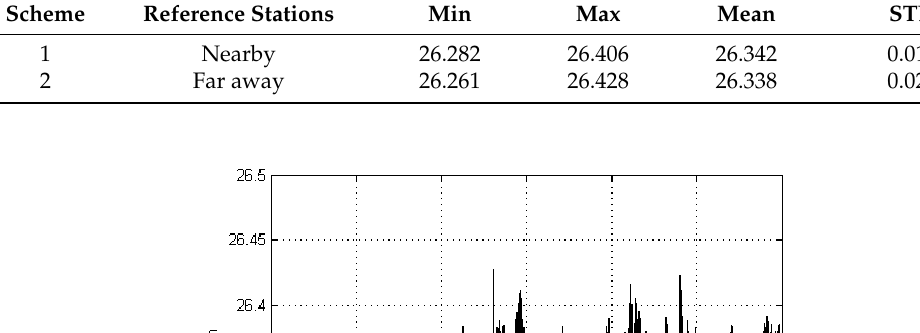
Table 2. The statistical results for the distance between KIN1 and KIN3 (Unit: m).